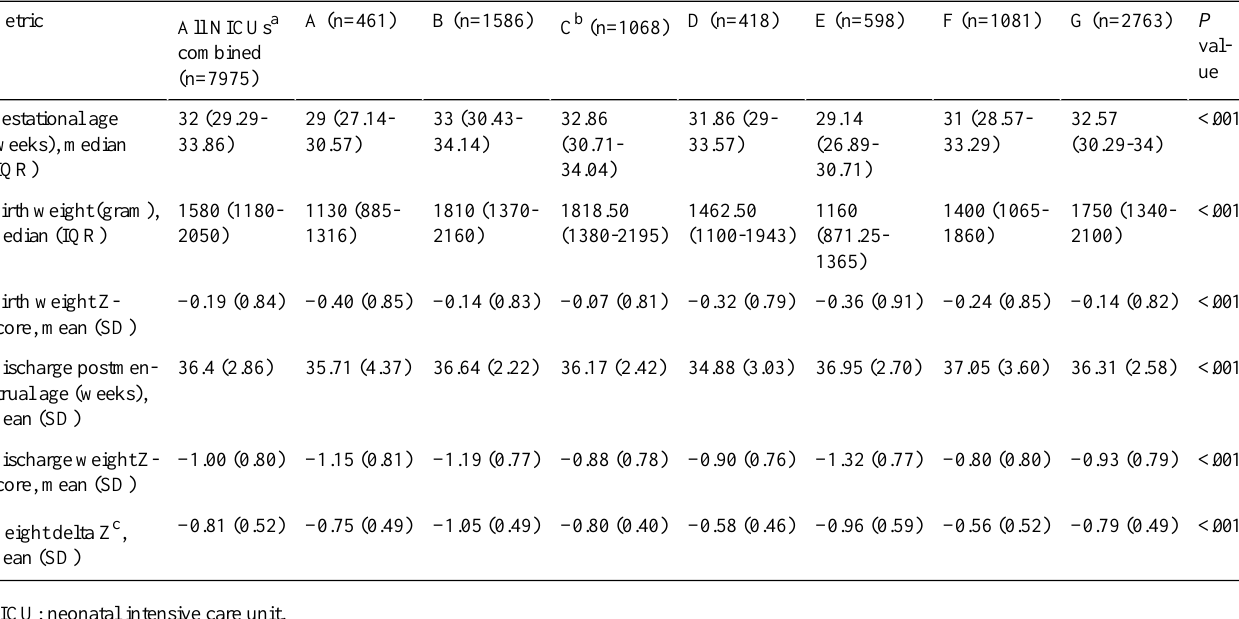
Table 3. Study population of 7975 premature newborns born between 23 and 34 weeks of completed weeks gestation in 7 Massachusetts newborn intensive care units